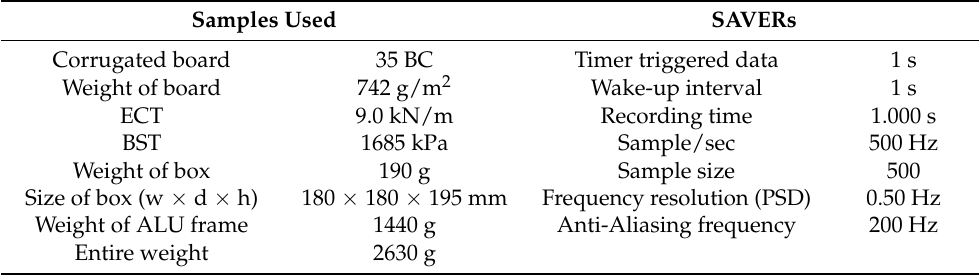
Figure 2. Applied sample packaging during the measurements, ( a ) the box and recording instrument ( b ) the instrument placed Table 1. Specifications for SAVER settings and sample used for this